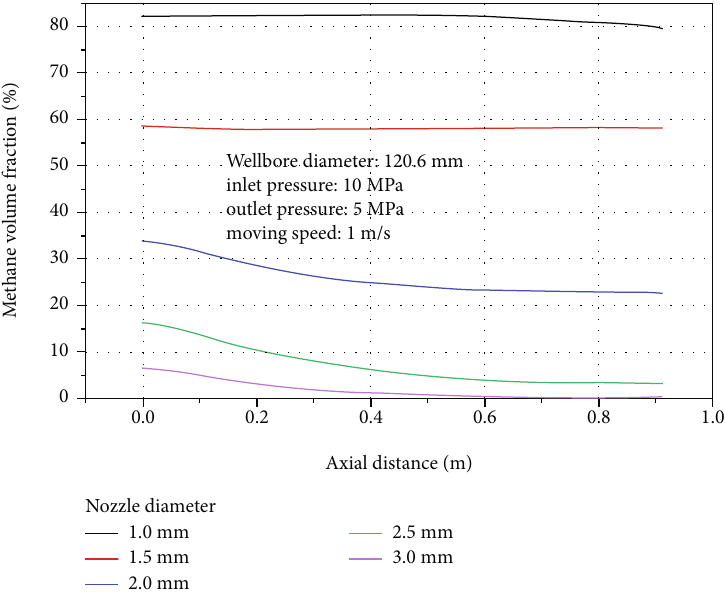
Wellbore diameter: 120.6 mm inlet pressure: 10 MPa